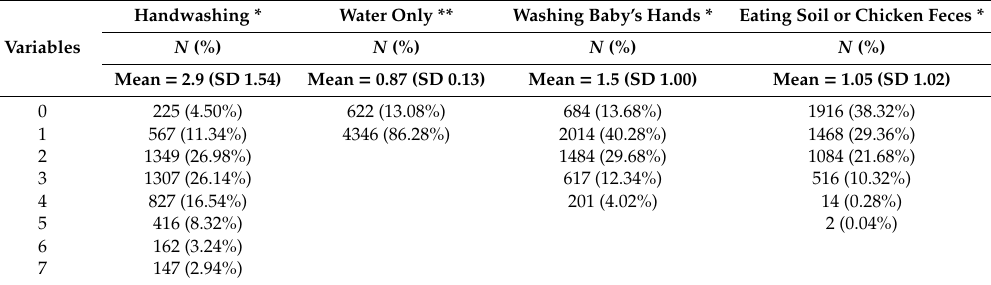
Table 2. Water, sanitation, hygiene (WASH)